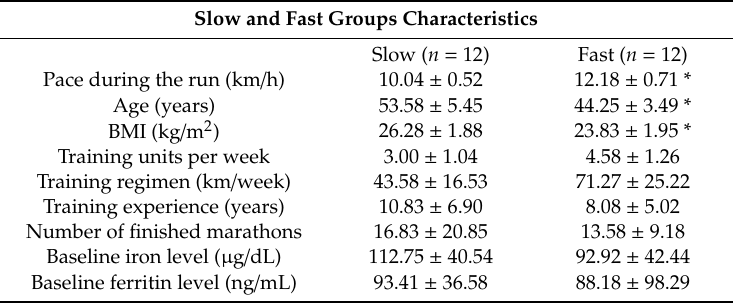
Table 3. Characteristics of slow and fast groups. Data are presented as means ± standard deviation (SD). * p < 0.05 for comparison between two